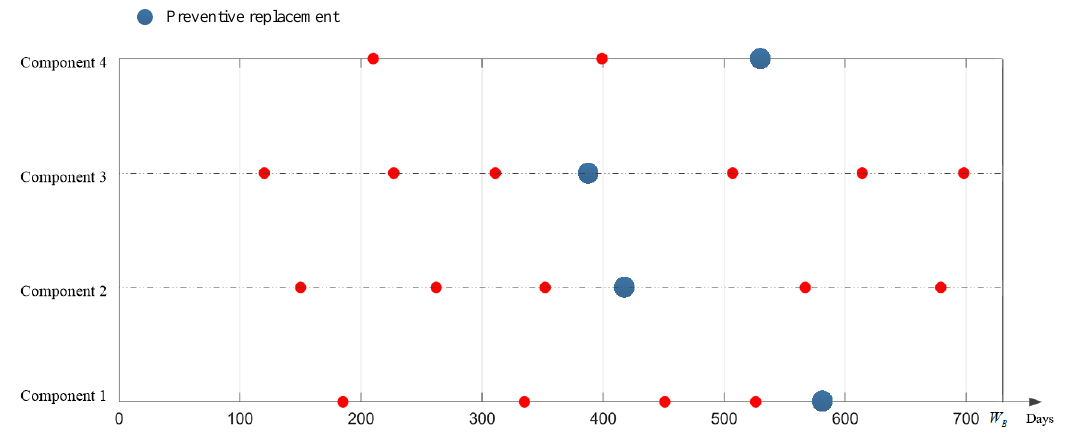
Figure 11. Preventive maintenance plan of the power transmission device.